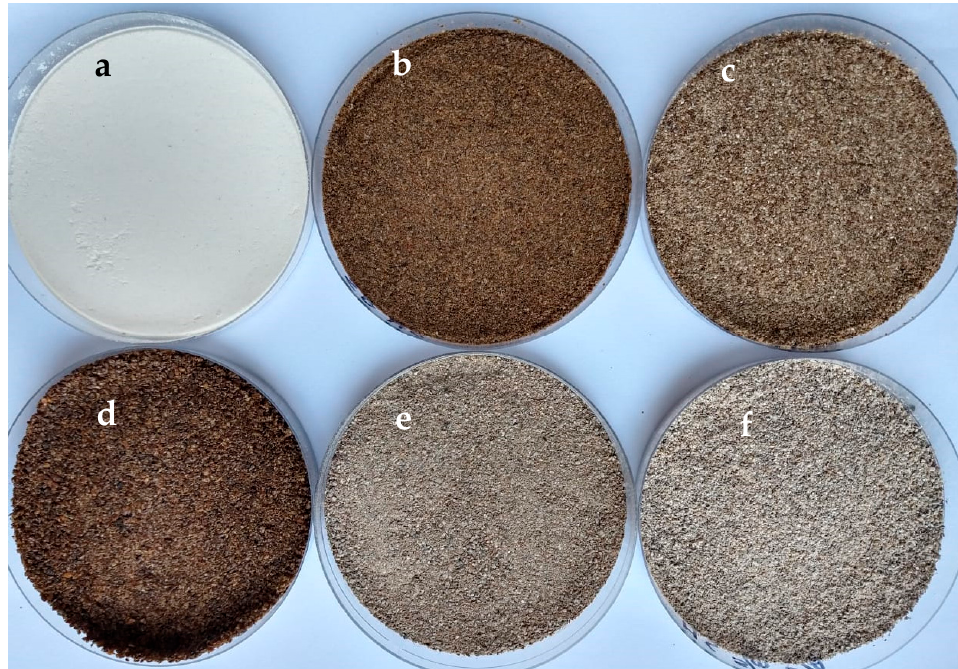
Figure 1. Raw materials: wheat flour ( a ); semi-defatted chia flour with mucilage ( b ); semi-defatted chia flour without mucilage ( c ); Whole chia flour ( d ); defatted chia flour with mucilage ( e ); defatted chia flour without mucilage ( f ).